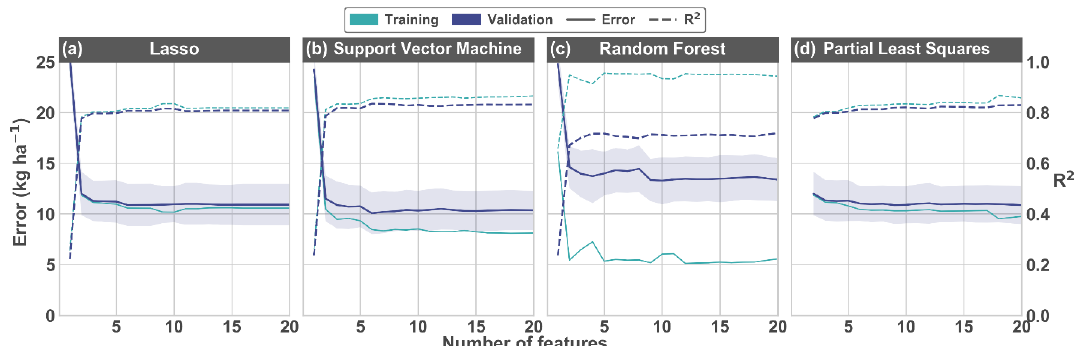
Figure 6. Influence of feature number on the mean absolute error (MAE) and coe ffi cient of determination (R 2 ) during hyperparameter tuning. The MAE and R 2 are illustrated for both the training and validation datasets for nitrogen uptake predicted by the ( a ) Lasso, ( b ) support vector regression, ( c ) random forest, and ( d ) partial least squares models evaluated in this study. The shaded region surrounding the validation error represents the standard deviation ( σ ) of error across the four folds and three repetitions of the repeated k-fold cross-validation applied during hyperparameter tuning.